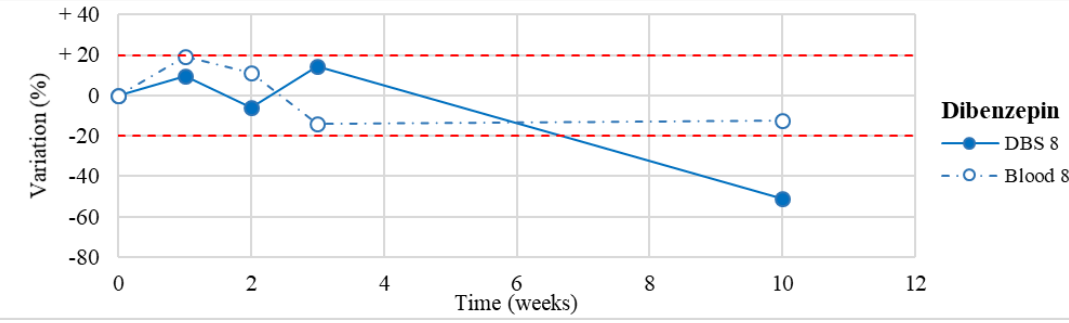
Figure 9. Long-term stability of dibenzepin ( n = 1) in DBSs stored at room temperature and in blood stored at −20 °C.